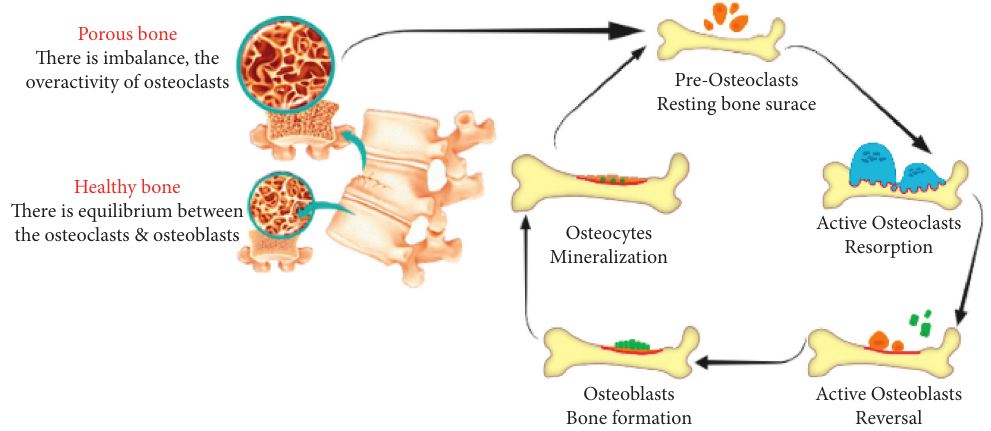
Figure 3: A proposed model for the potential osteoprotective effects of minerals [39]. Table 9: Comparison of the analytical features of the proposed method with those of other reported methods for the determination of metallic elements in fruit peel samples. Element Technique Time Extracting solvent Reference